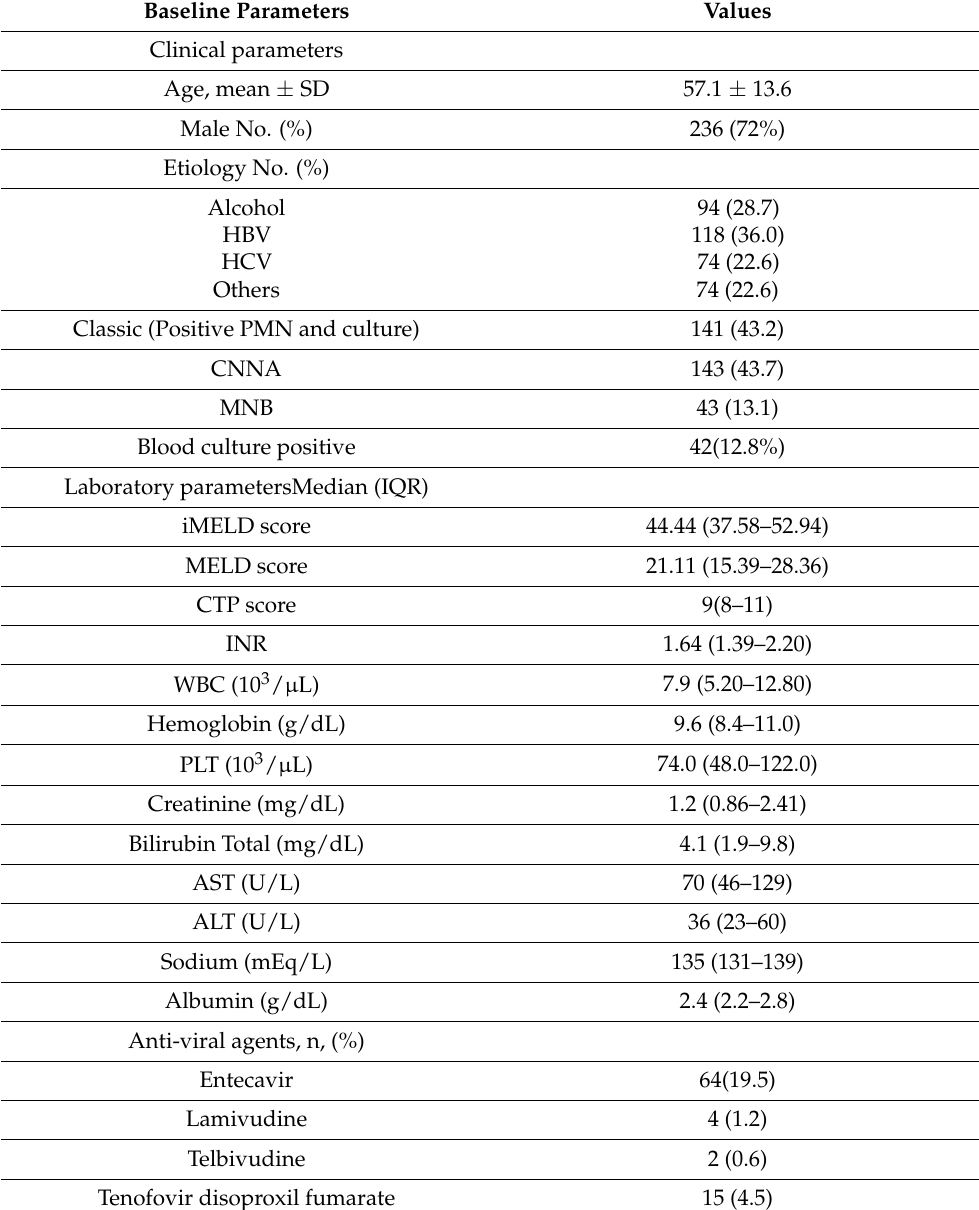
Table 1. Demographic and baseline clinical characteristics of 327 patients with the first episode of SBP. Baseline Parameters Values Clinical parameters Age, mean ± SD 57.1 ±